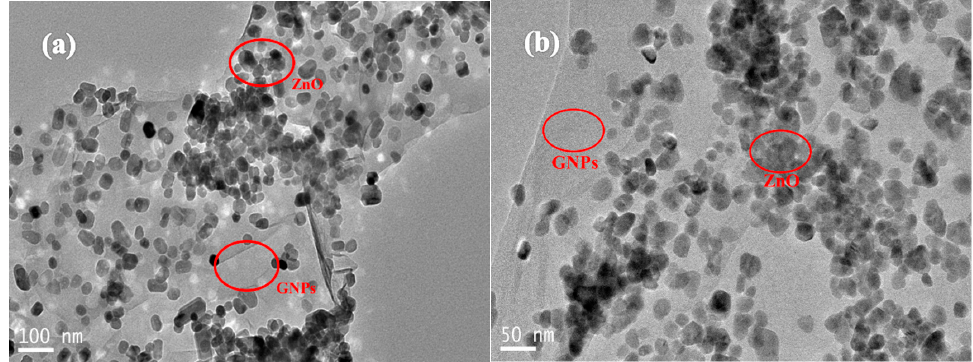
Figure 3. TEM micrograph ( a ) and highly-magnified TEM ( b ) of the GNP-ZnO hybrids suspension.